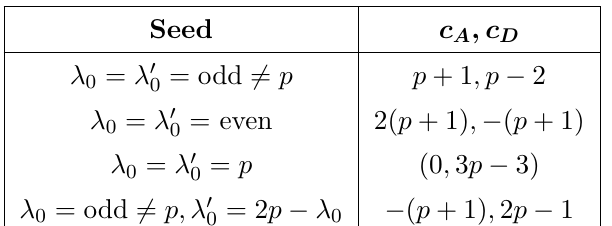
Table 3. General result, two modular invariants. The seeds are labelled by λ 0 , λ 0